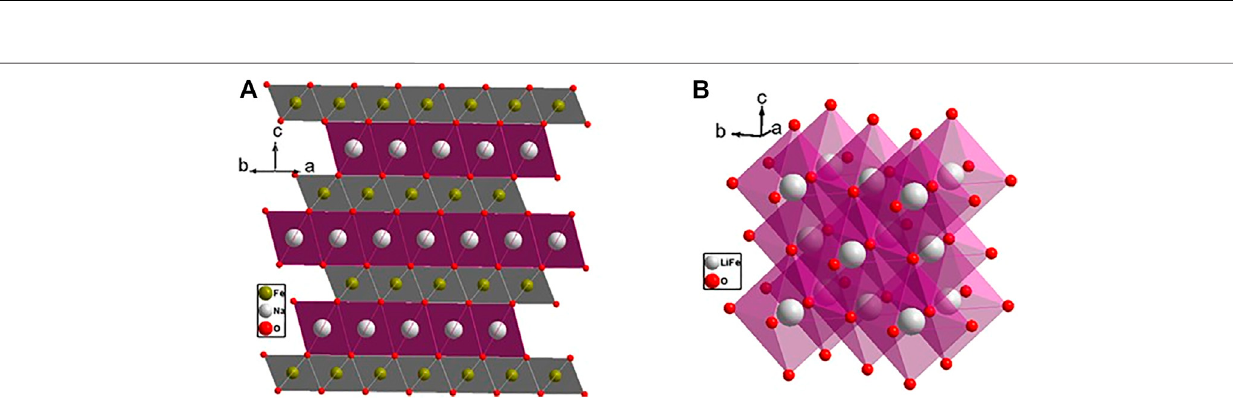
Frontiers in Chemistry |